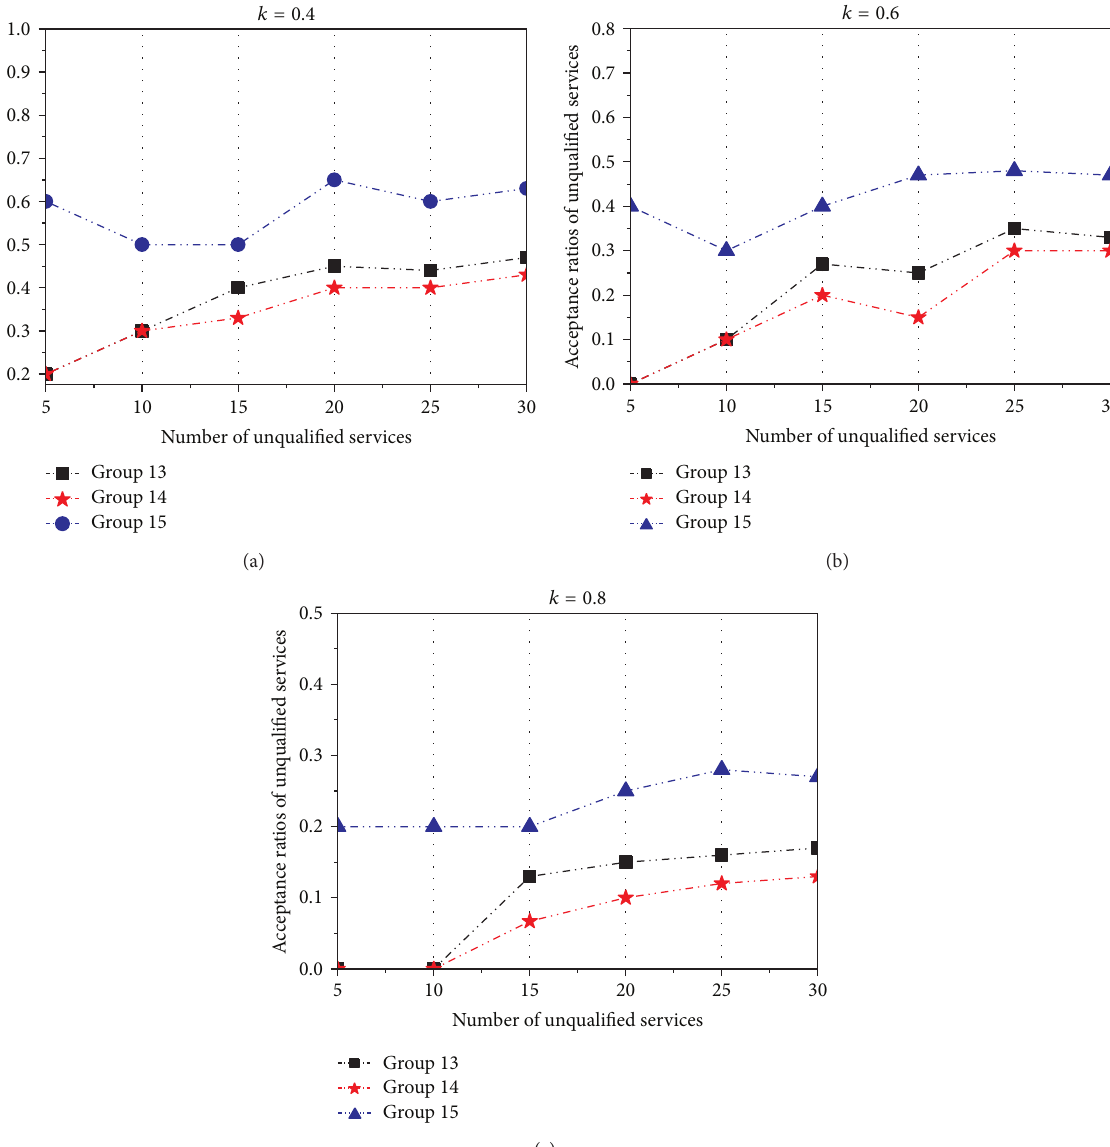
Figure 5: Effects of recommended trust computation parameter